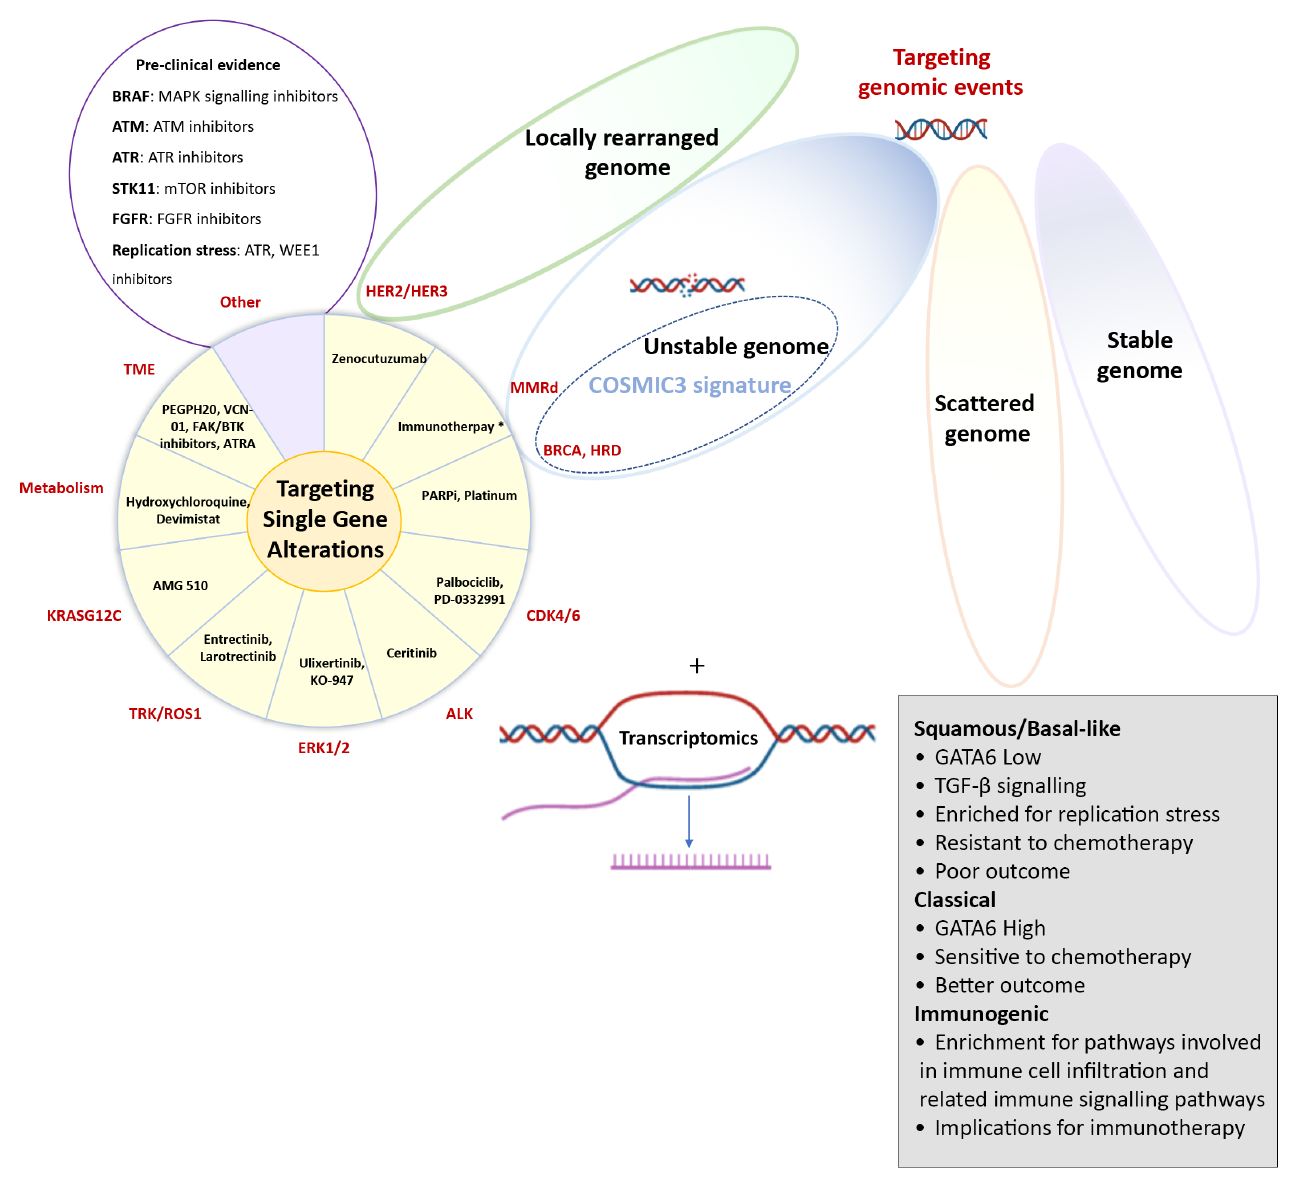
Figure 1. Molecular targets in pancreatic cancer. Potential molecular targets in pancreatic cancer, including therapeutic targeting of single-gene alterations, or possibly larger subgroups that are identified by whole genome sequencing (locally rearranged or unstable genomes), mutational signatures or transcriptomic subtypes. The pie diagram shows specific compounds currently under clinical investigation based on single-gene alterations or targeting the stroma or altered metabolism. However, this list continues to expand and “Other” includes potential other targets based on encouraging preclinical evidence with various drugs with similar mechanisms of action being